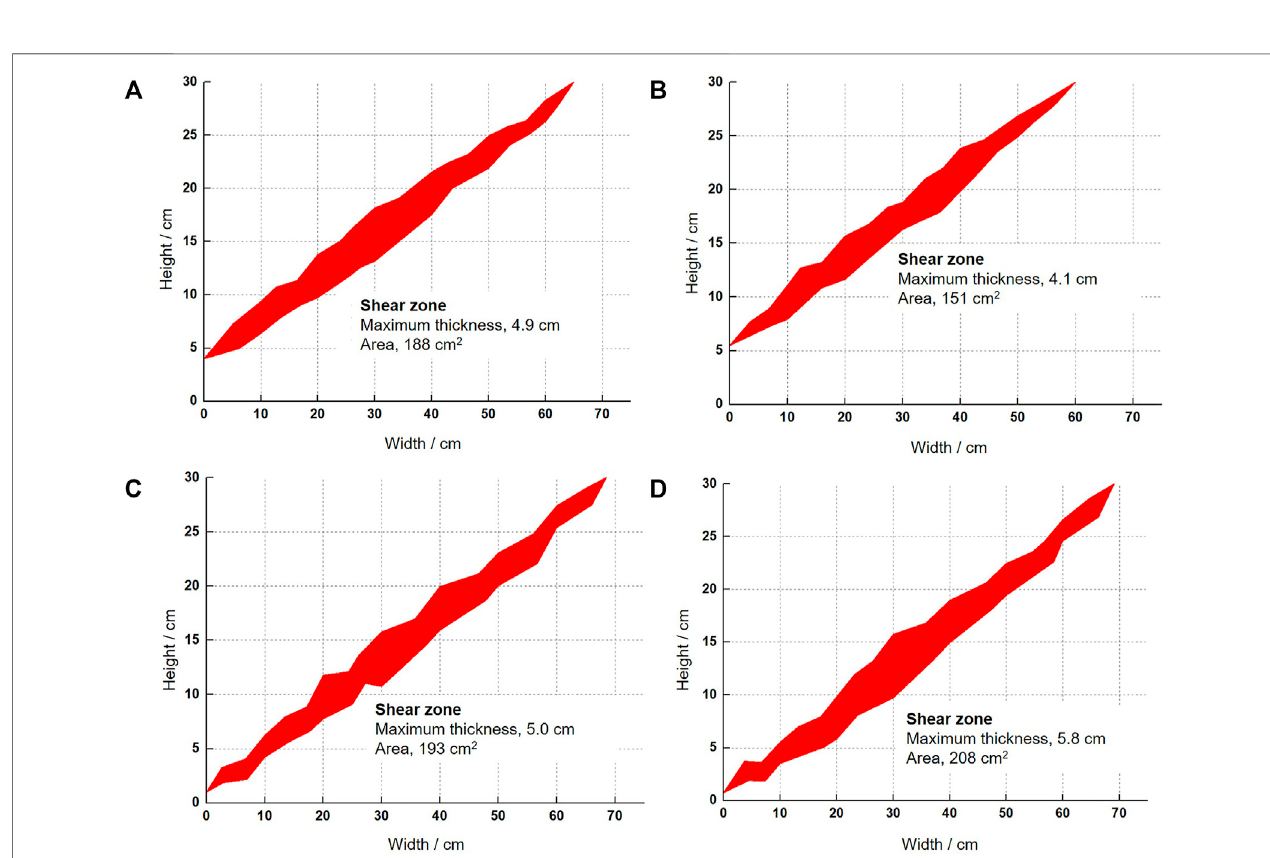
Frontiers in Earth Science |